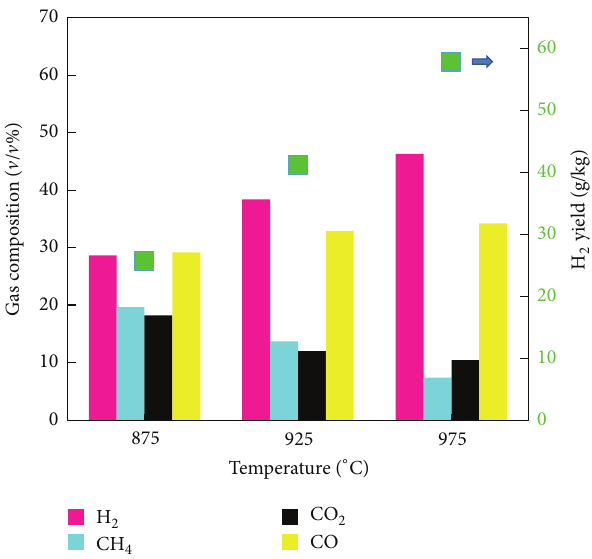
Figure 2: Influence of temperature on H 2 -rich gas